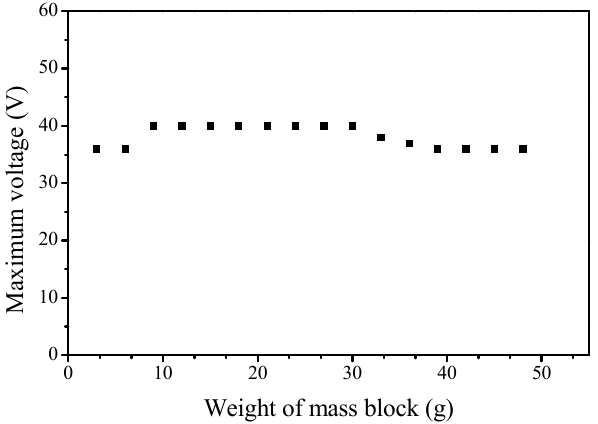
Figure 16. Weight of mass versus maximum voltage in cantilever beam fixation mode.